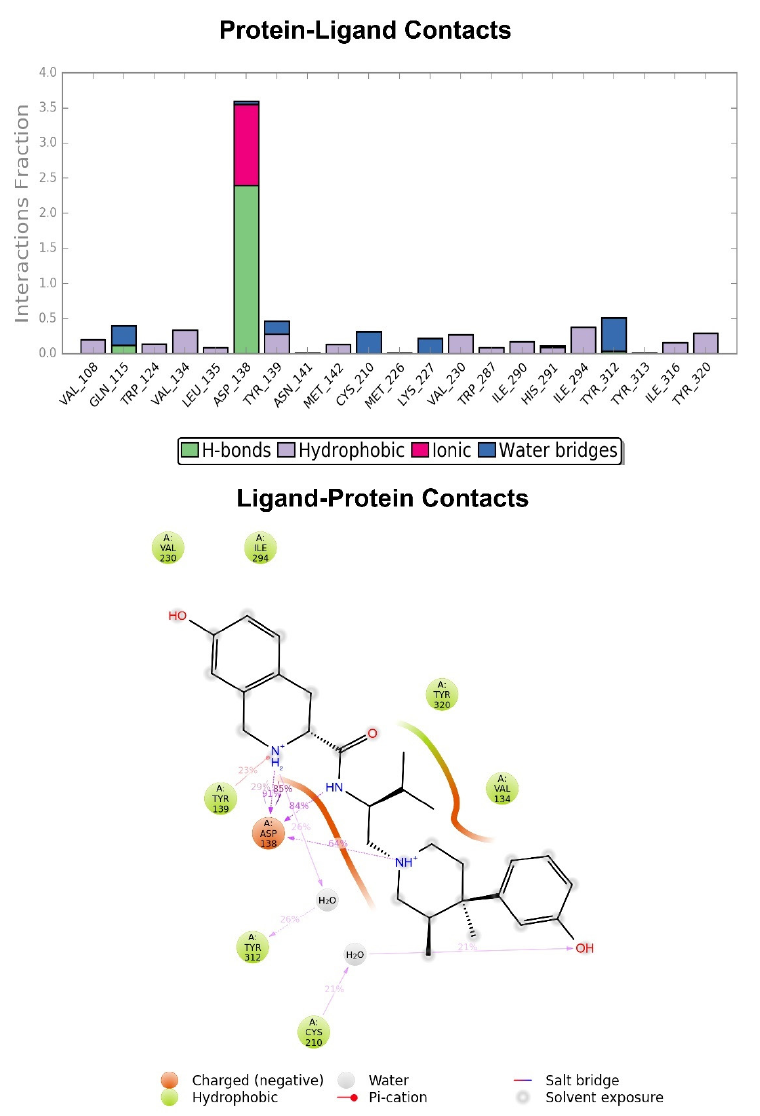
Figure 4. Graphic representation of the interactions between the JDTic and KOR binding site, expressed in %. Hydrogen bonds are in violet lines.